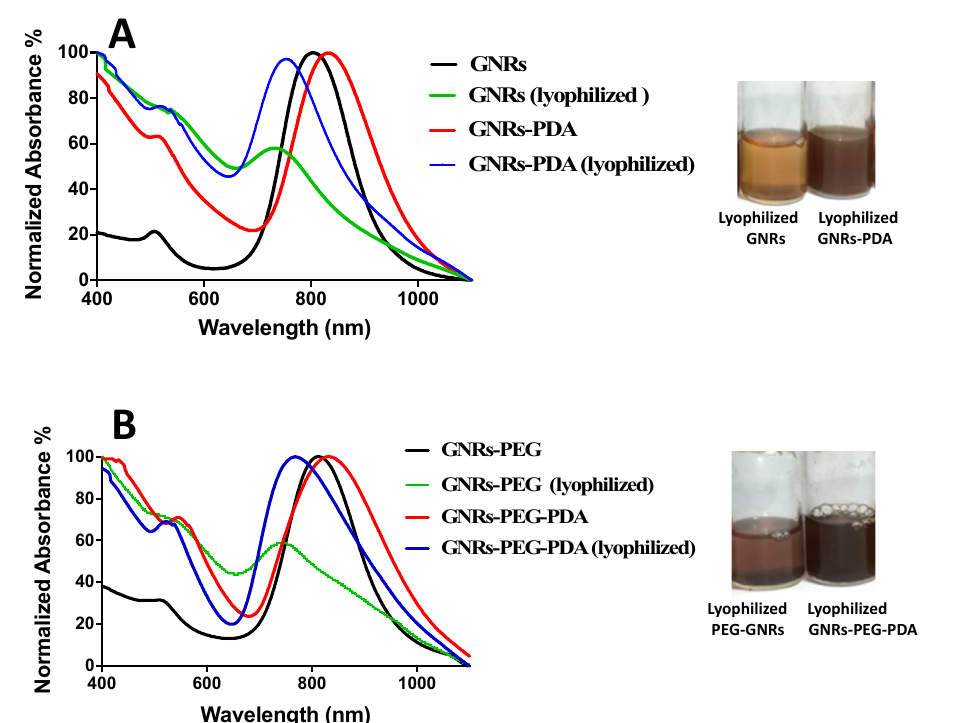
Figure 3. ( A ) UV-Vis absorption spectra of GNRs and GNRs-PDA before and after lyophilization. ( B ) UV-Vis absorption spectra of GNRs-PEG and GNRs-PEG-PDA before and after lyophilization. The photos indicate loss of the colloidal stable color and aggregation of the lyophilized GNRs and GNRs-PEG compared to lyophilized GNRs-PDA and GNRs-PEG-PDA, which have a superior colloidal stability.